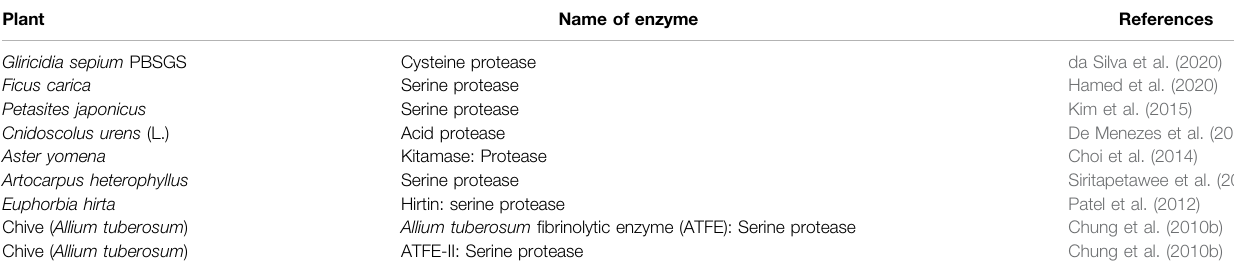
TABLE 5 | Fibrinolytic enzymes produced by plants.